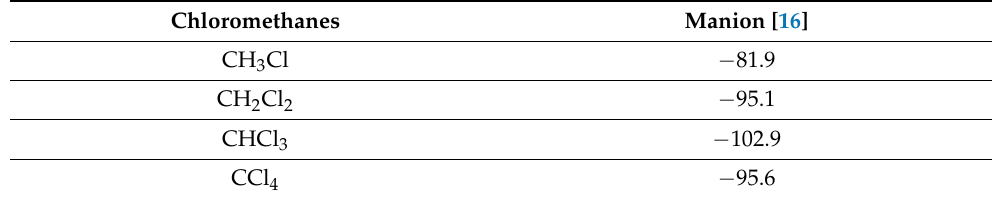
Table 1. Experimental values for the heat of formation of chloromethanes in the gas